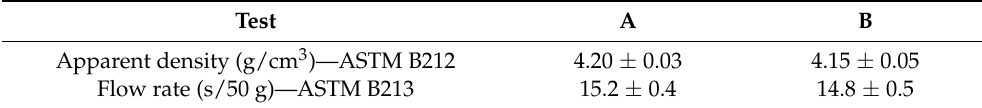
Table 5. Flowability measurements.